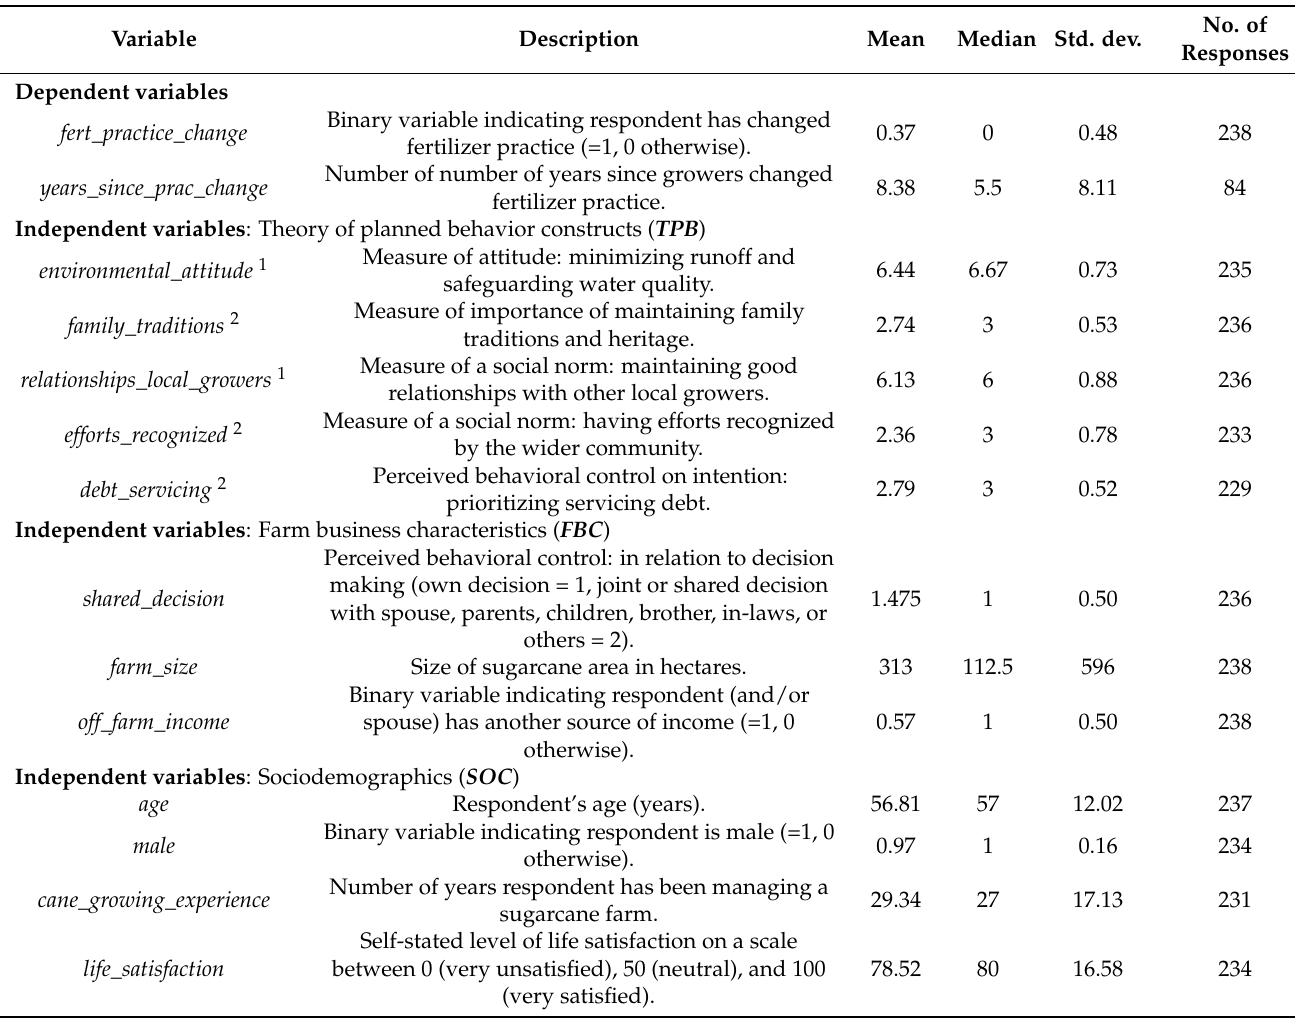
Table 1. Descriptive statistics of variables included in the logistic and count data regression models. The number of responses for each variable reflects the number of complete answers